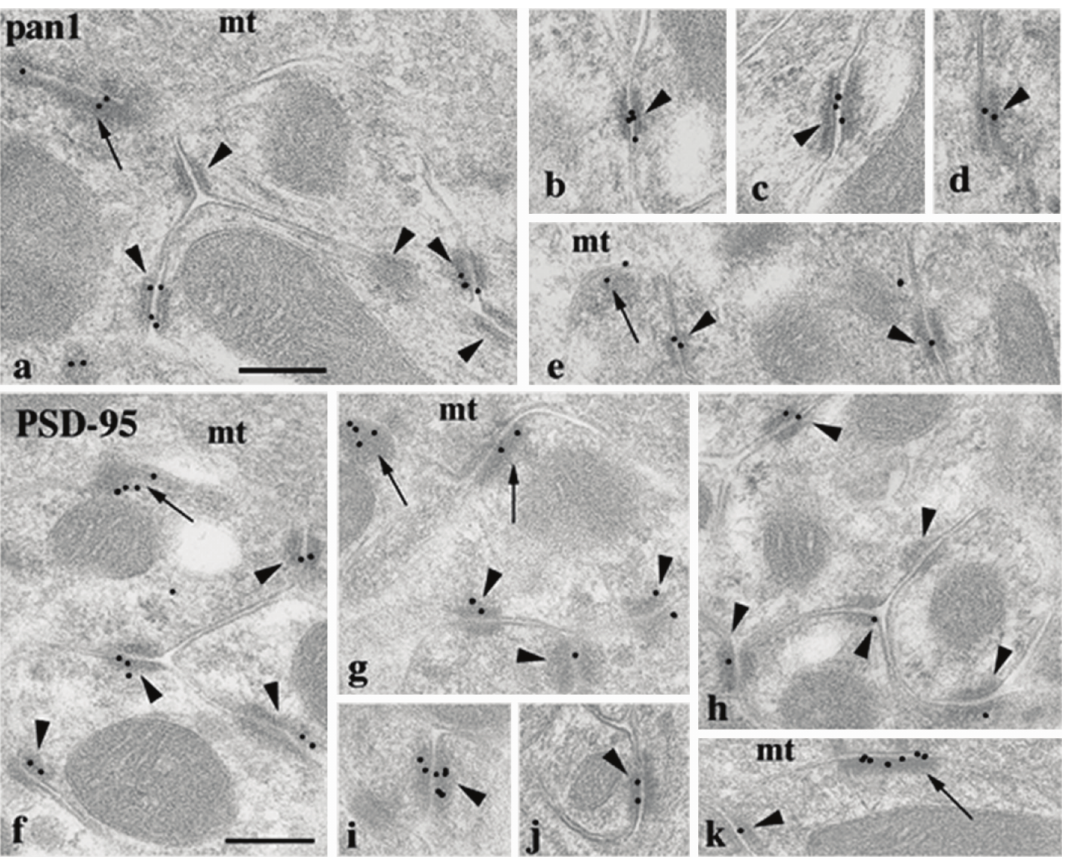
Figure 5: Localization of NMDAR (a–e) and PSD-95 (f–k) antibody labeling mossy terminal glomeruli in the cerebellar granular layer. The pan1 NMDAR antibody is shown here but this was corroborated using 3 more NR1 and 1 NR2A/B antibodies (see Petralia et al. [36] for details). Labeling is limited mainly to synapses (arrows: between the mossy terminal (mt) and dendrite processes from granule cells) and attachment plaques (arrowheads: mainly between granule cell dendrite processes). Scale bar is 200 nm. Reprinted from parts of Figures 2 and 3 from Petralia et al.